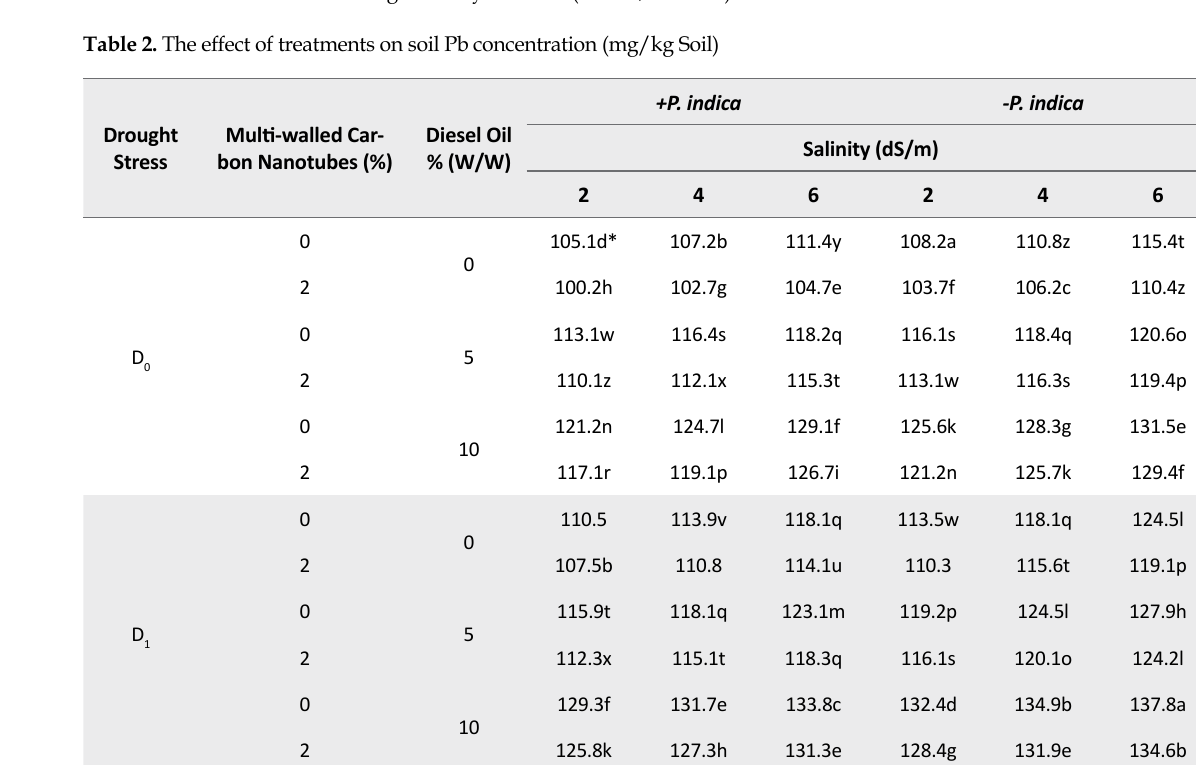
Table 2. The effect of treatments on soil Pb concentration (mg/kg Soil)